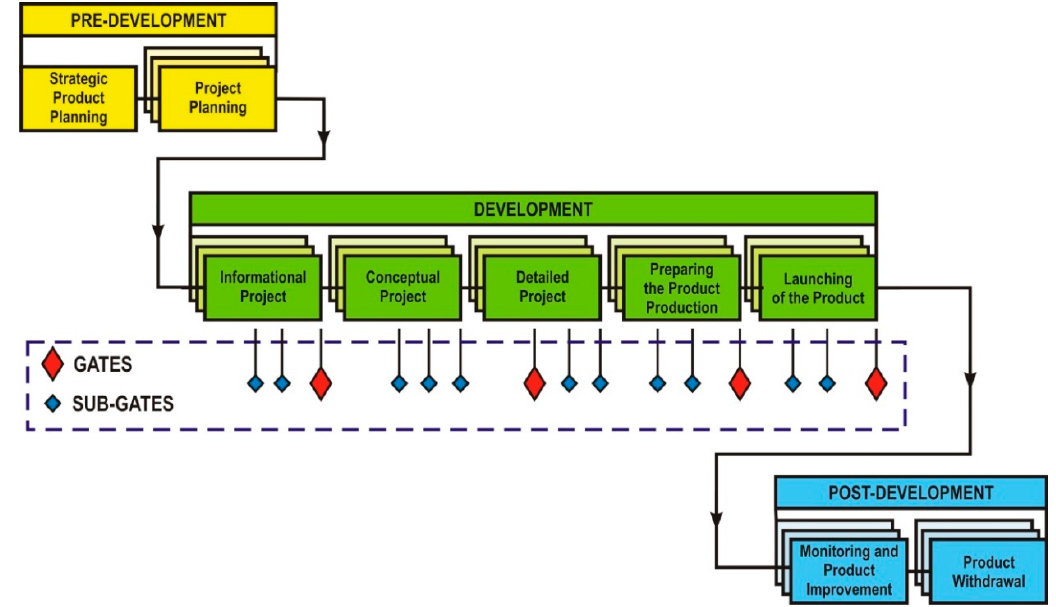
Figure 1. The product development process (PDP) Unified Model. Source: own study.